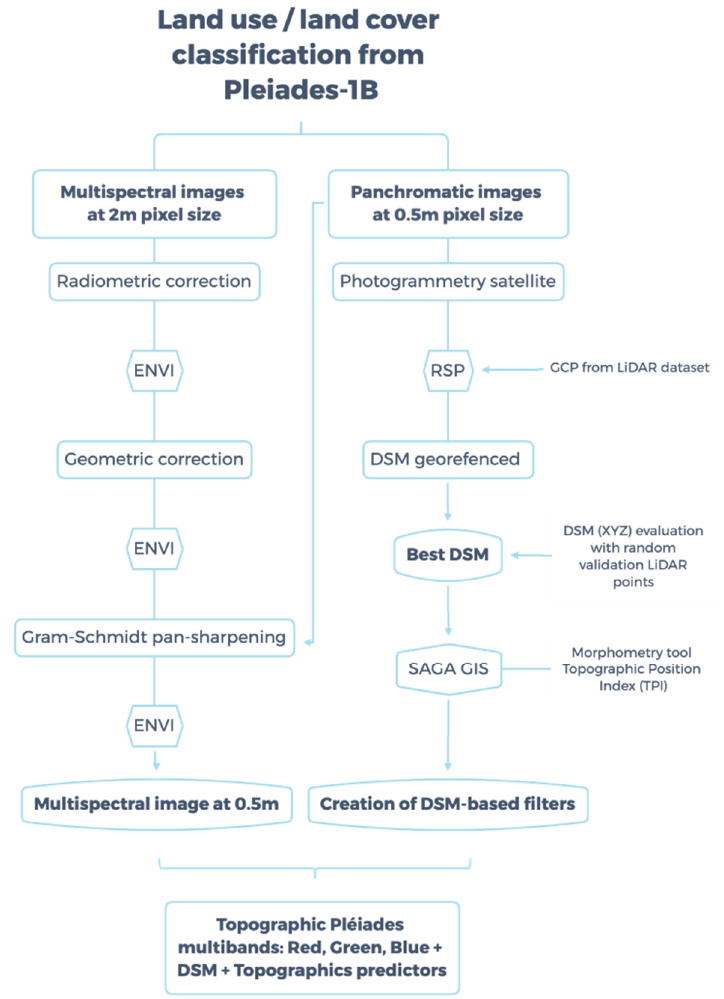
Figure 5. Flowchart describing methodology for coastal landscape classification from Pleiades–derived topography and morphometry.